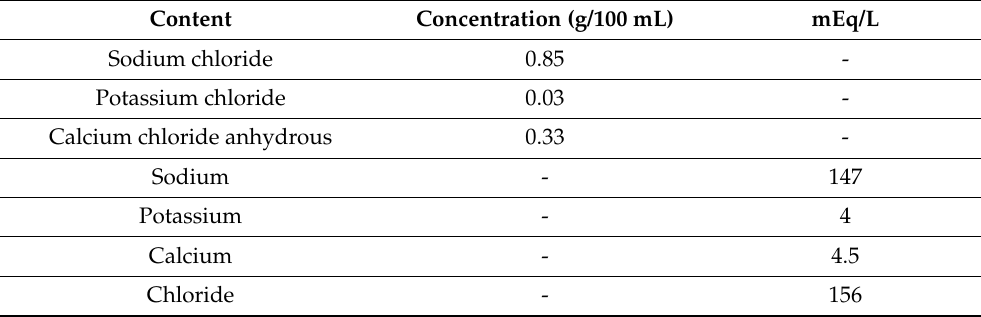
Table 3. Ringer’s solution chemical